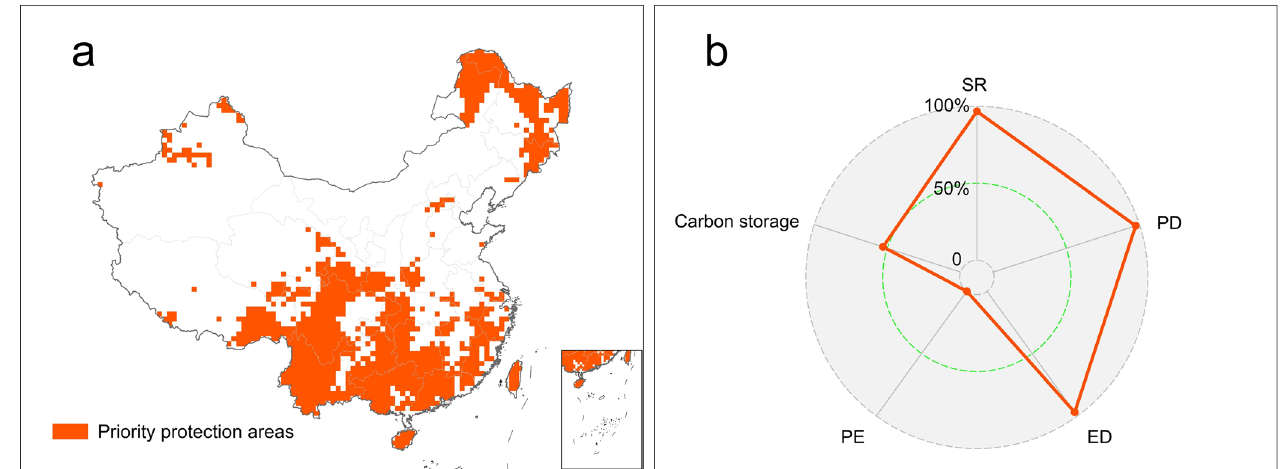
Figure 1. ( a ) Map of priority protection areas (PPAs) for plant diversity and carbon storage. PPAs were set as the 30% of land area with the highest combined value of taxonomic diversity (TD; i.e., species richness; SR), evolutionary history-related indices (e.g., phylogenetic diversity; PD, phylogenetic endemism; PE and evolutionary distinctiveness; ED), and carbon storage. The weights of taxonomic diversity, evolutionary history-related indices and carbon storage were equal. PD, PE and ED were also set the same weight, ( b ) Proportion of SR, PD, ED and carbon storage covered in the PPAs. The dotted circles show the proportion range of 0-100%. The orange line shows the extent to which the PPAs contribute to the protection of SR, PD, ED and carbon storage. Because the calculation of PE was related to the geographical extent of each branch, the percentage of PE coverage cannot be calculated.